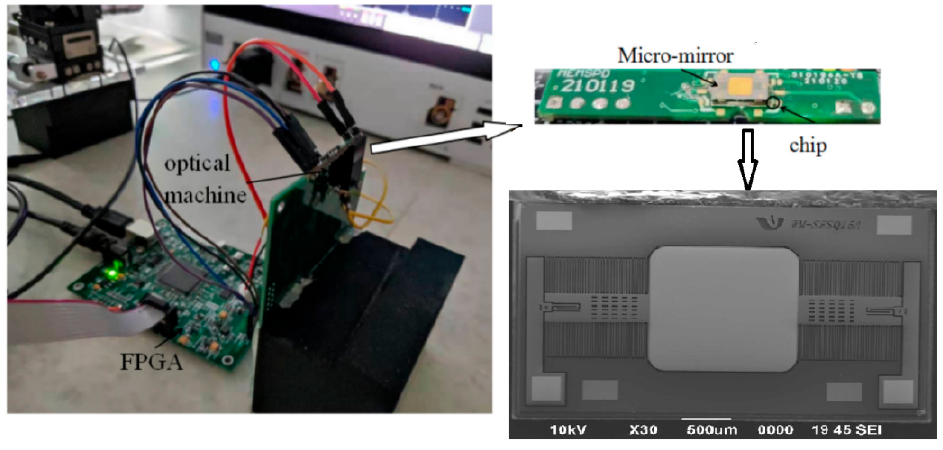
Figure 18. A photo of the experimental setup.